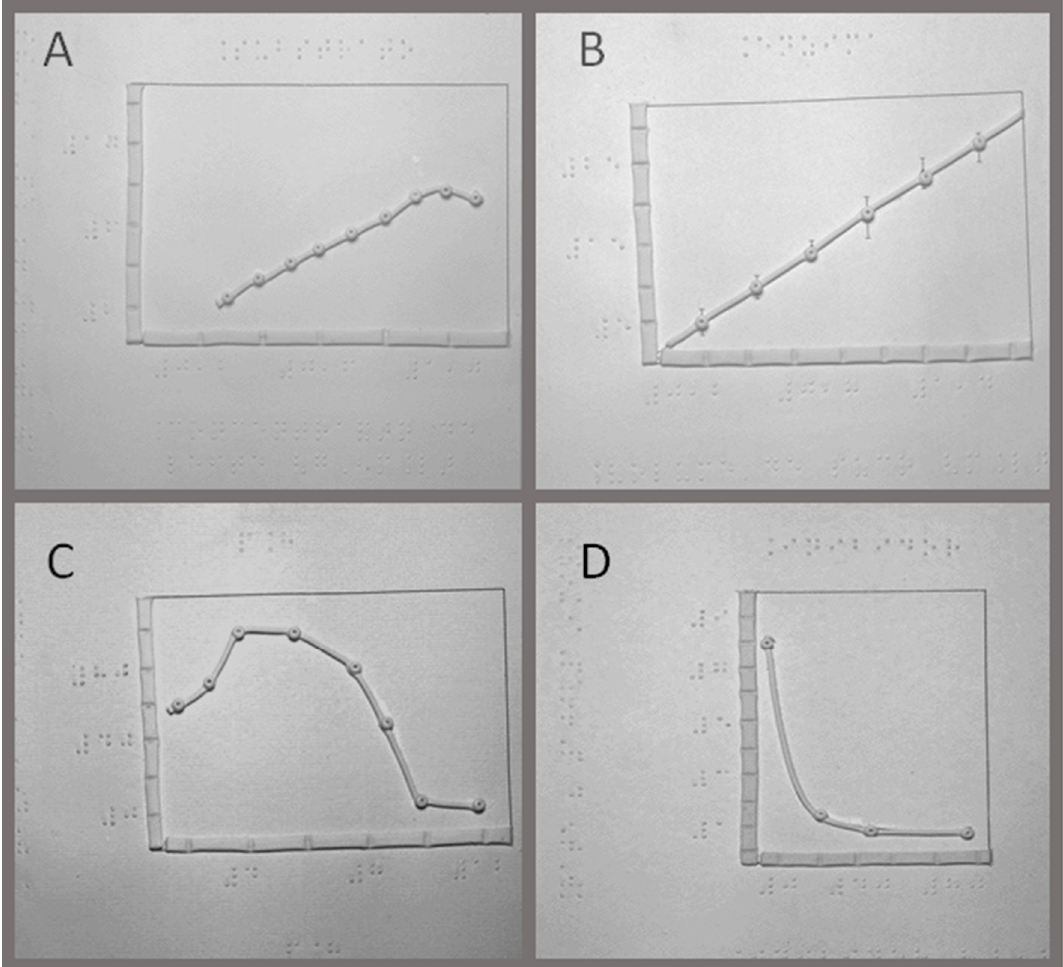
Figure 3. 3D representation of graphs. The graphs were printed in a 180 g/m 2 paper and the lines and curves were covered up with cold porcelain. The paper was glued in medium-density fiberboard (MDF) boards after the legends and numbers were written in Braille by using a positive slate. The rates are represented as the inverse of the time needed to reach the end of the reaction (min − 1 ) since the product concentration cannot be determined. ( A ) Effect of substrate concentration: the rate of the reaction (Y axis) varies from 2 to 12 (min − 1 ) and the substrate concentration indicated were: 0.2, 0.6, and 1.0 g/mL of milk. ( B ) Effect of enzyme concentration: the rate (Y axis) of the reaction varied from 0 to 30 h − 1 , and the numbers in Braille are for 5, 15, and 25 (h − 1 ). The enzyme concentration varied from 0 to 1.4 mL of juice. ( C ) Effect of pH: The activity of the enzyme (Y axis) was calculated as a percentage of the highest value obtained in pH 4, and the numbers in the plot indicate the 0%, 40%, and 80% of activity. The pH ranged from 2 to 12, and the numbers in Braille are for pH 4, 8, and 12. ( D ) Effect of Inhibitor: shows the rate (Y axis) as 1, 3, 5, 7, and 9 min − 1 as a function of inhibitor concentration (X axis): 0%, 40%, and 80% of inhibitor are indicated in Braille.